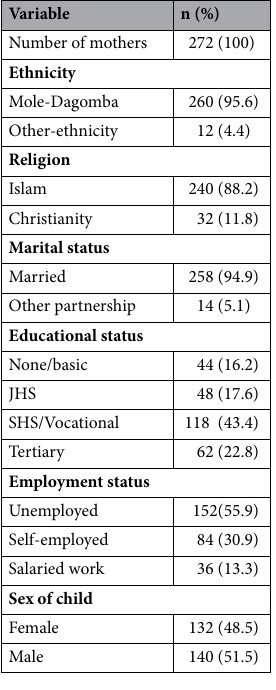
Table 3. Sociodemographic variables (categorical) of the mothers involved in the study. Results of socio- demographic characteristics for categorical variables of the 272 mothers presented as number (per